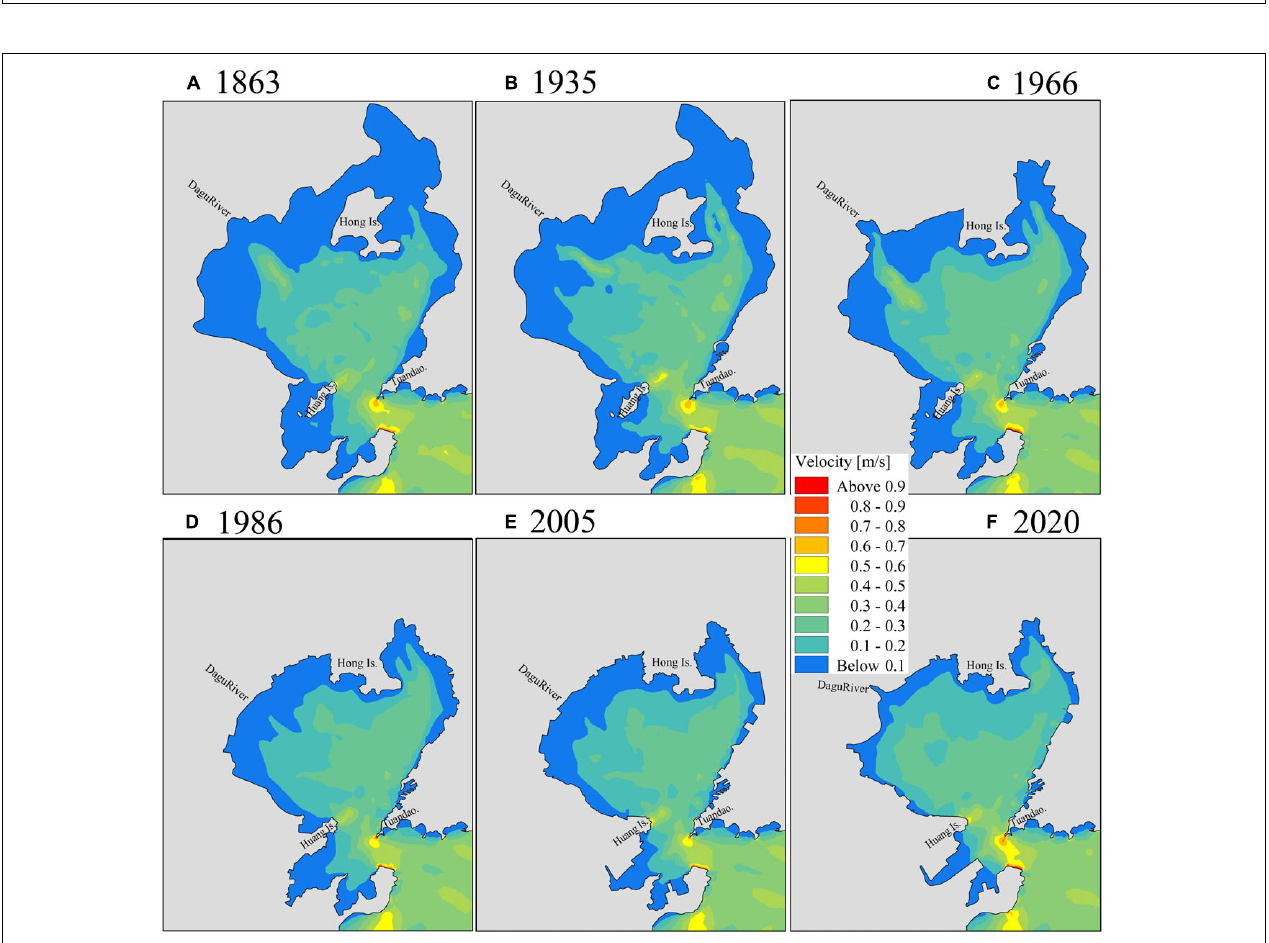
FIGURE 7 | Distributions of mean tidal velocity in (A) 1863 (B) 1935 (C) 1966 (D) 1986 (E) 2005 (F) 2020.